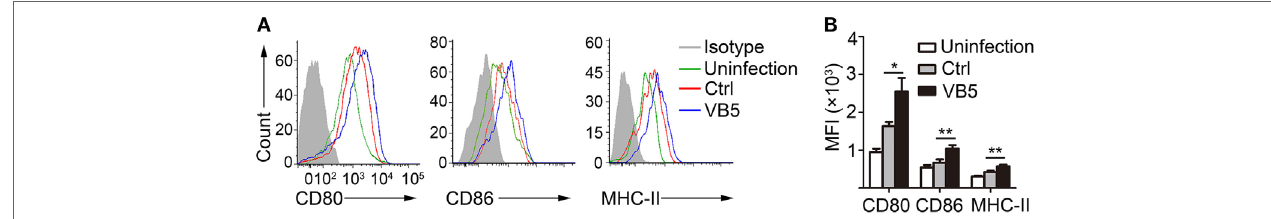
FigUre 3 | The expressions of CD80, CD86, and MHC-II on bone marrow-derived macrophages (BMDMs). (a) BMDMs were pretreated with vitamin B5 (VB5) or not (Ctrl) for 24 h and infected with Mycobacterium tuberculosis H37Rv for 24 h. The expressions of CD80, CD86, and MHC-II were detected via flow cytometry. Untreated and uninfected BMDMs were as the negative controls (Uninfection). Data are representative of three independent experiments with similar results. (B) The expressions of CD80, CD86, and MHC-II were assessed as mean fluorescence intensity (MFI).